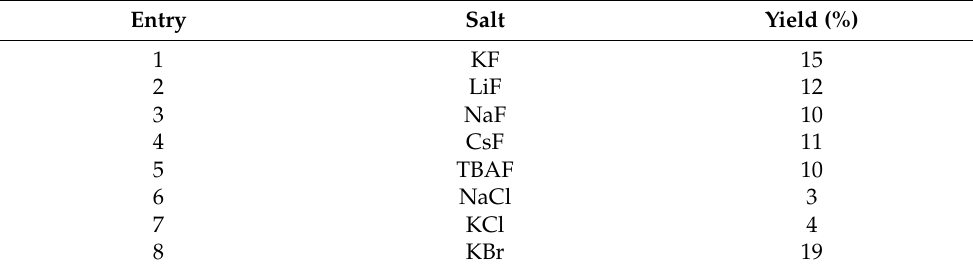
Table 3. Toluene oxidation in biphasic system (V = 20 mL; PhCH 3 :H 2 O 1:1 v/v ), pH =